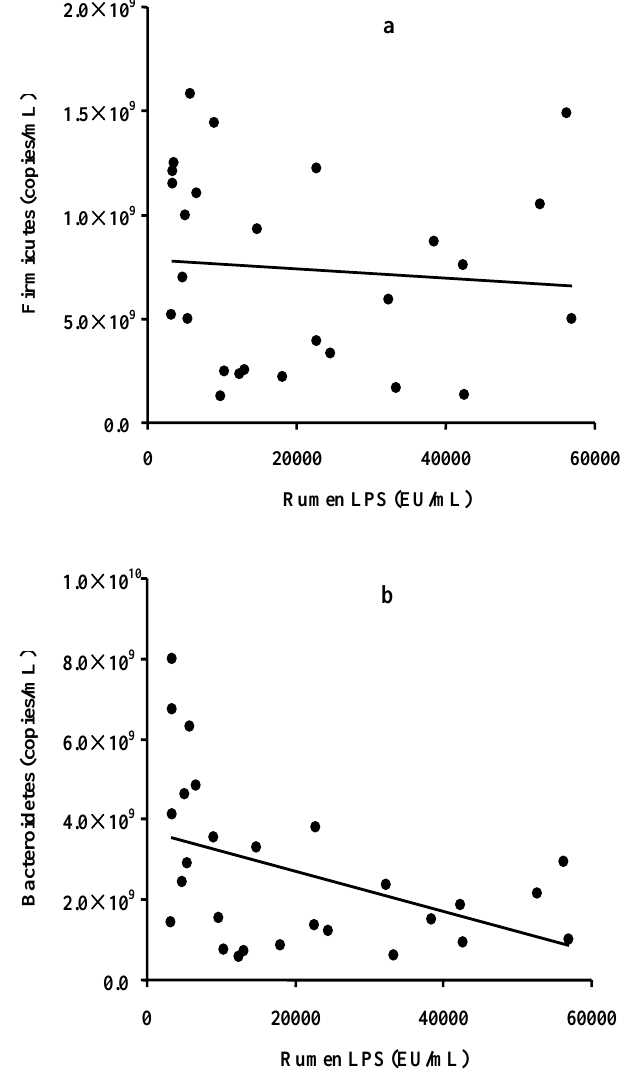
Figure 2. Correlations between the copy numbers of rumen Firmicutes (a) or Bacteroidetes (b) and the rumen LPS